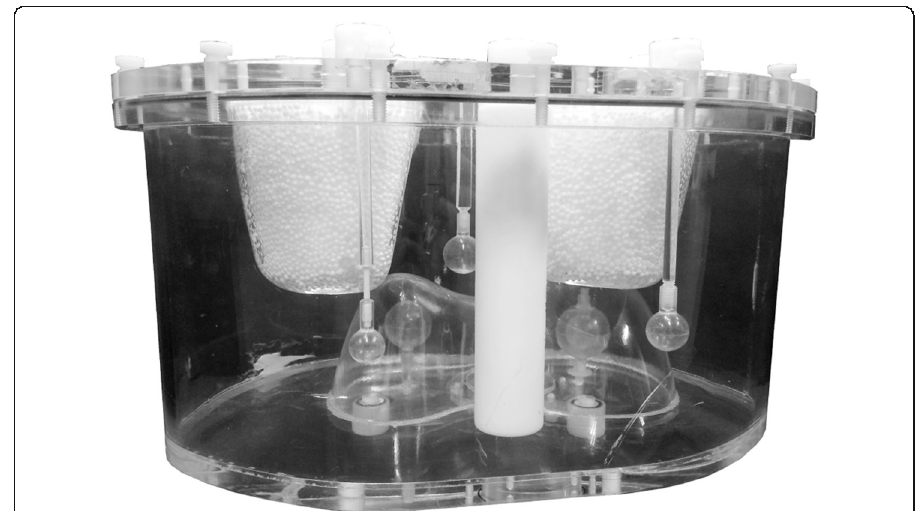
Fig. 2 The anthropomorphic phantom with three extrahepatic volumes and one solid lesion and one lesion with a cold core inside the